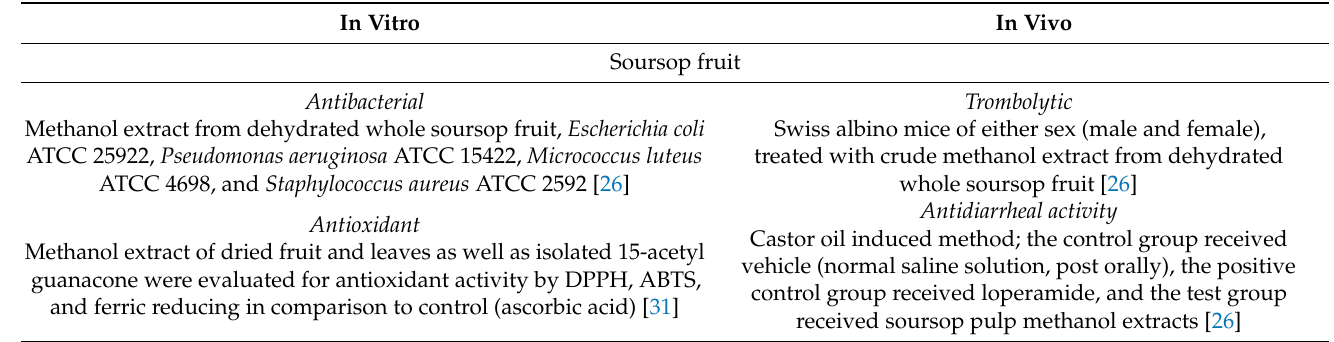
Table 2. Details of in vitro and in vivo assays of the properties of different parts of soursop ( Annona muricata )